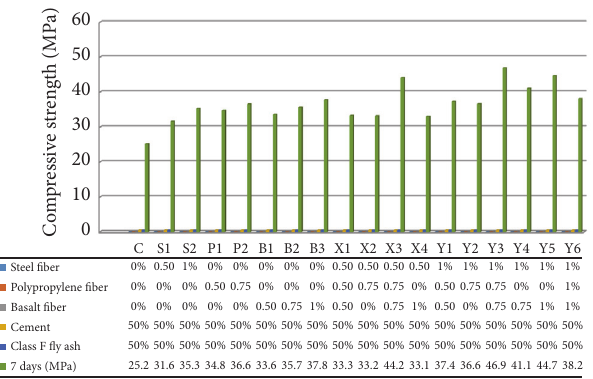
Figure 1: Comparison of compressive strength between control concrete (50% cement, 50% fly ash, and no fibers) and hybrid fiber mixes at 7 days.